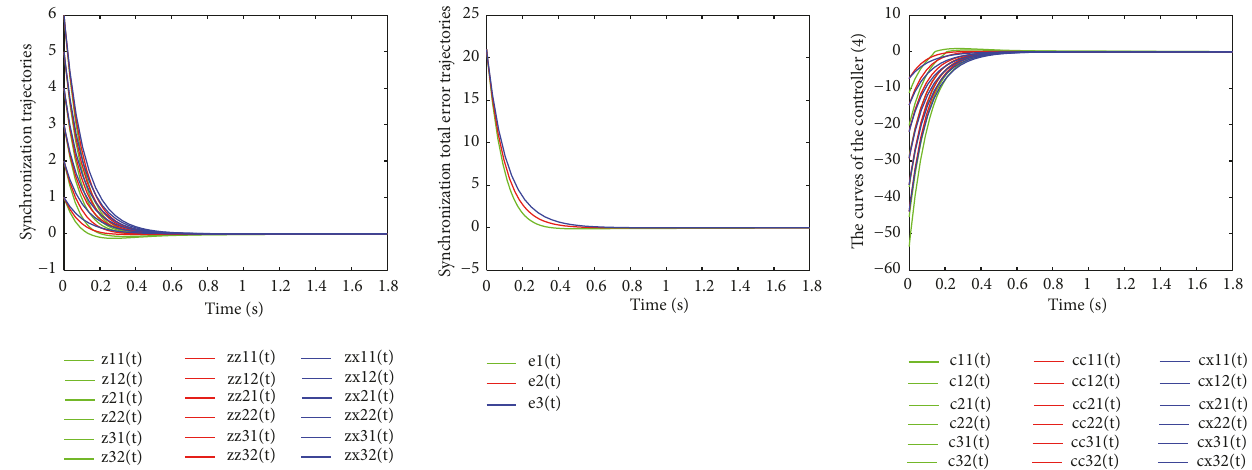
Figure 2: Synchronization trajectories, synchronization total error trajectories of network (1) with controller (4) and the curves of controller (4) for Case II of Example 25.